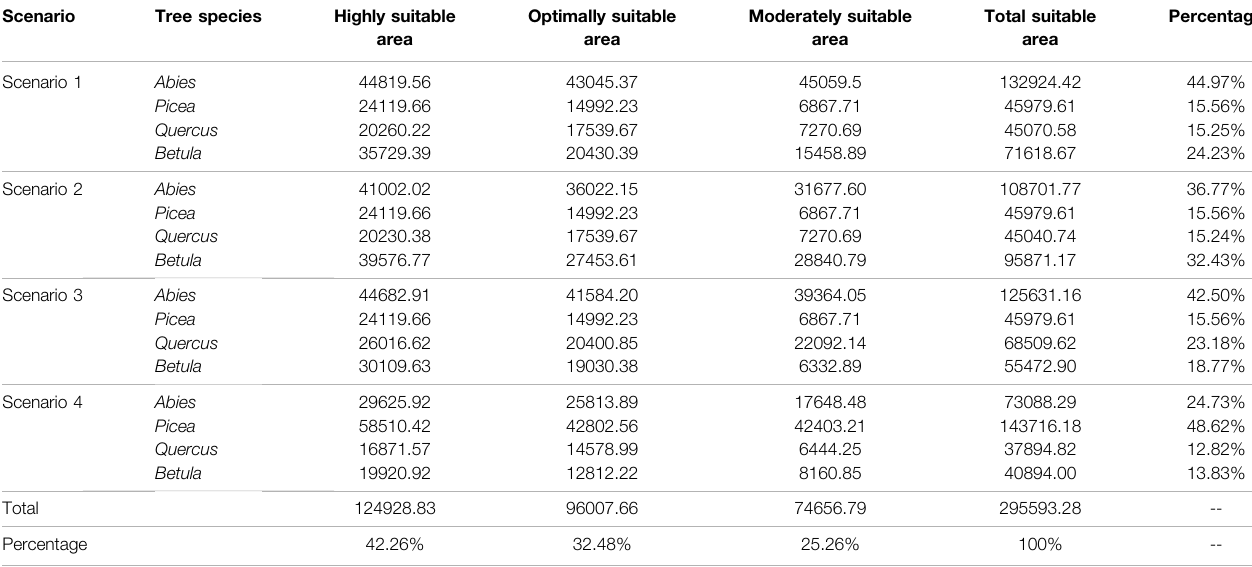
TABLE 2 | Distributions of different suitable areas for four dominant tree species under four scenarios